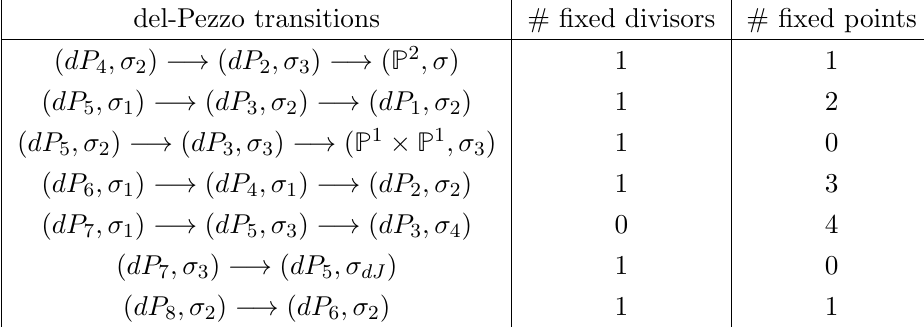
Table 2 . The Z 2 -invariant del-Pezzo transitions that lead to conifold singularities in the associated CY threefold that avoid the O-plane loci. Across each transition both h 1 ; 1 one. In the (cid:12)rst (cid:12)ve lines, two subsequent transitions are possible leading to jumps of h 1 ; 1